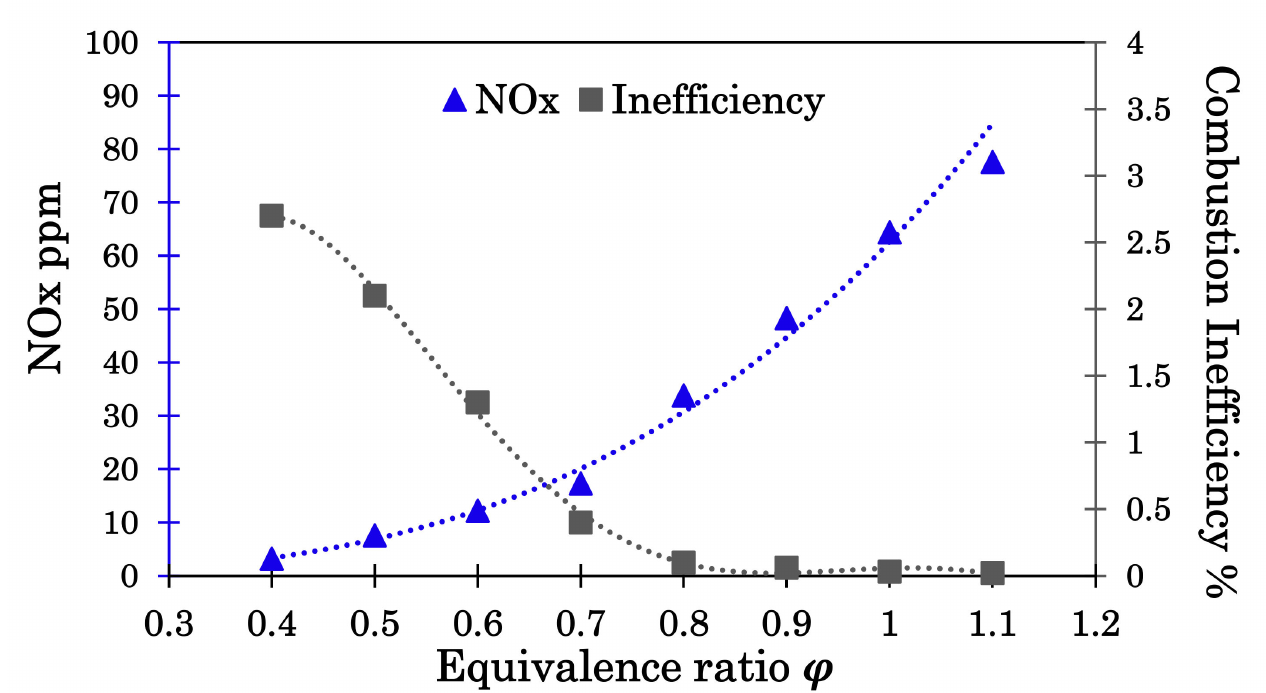
Figure 5. Emission and combustion inefficiency